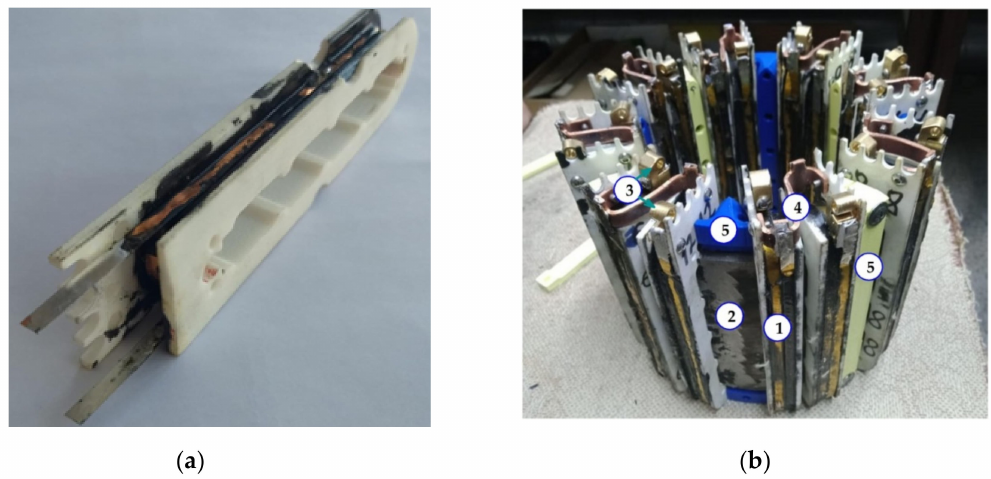
Figure 4. ( a ) Manufactured racetrack coil prepared for soldering of current leads and potential taps; ( b ) assembled package of annular stator winding (without wiring). 1—HTS coil, 2—iron yoke, 3—brass connectors, 4—copper bridge between coupled coils, and 5—positioning elements between